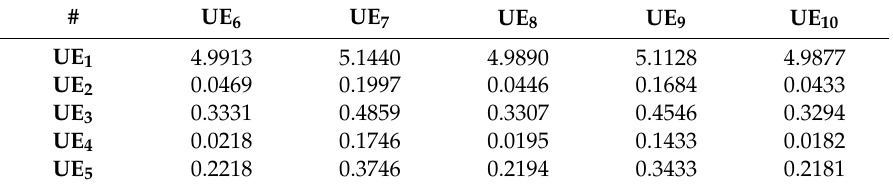
Table 1. User pairing description in the Hungarian algorithm for sum rate maximization.